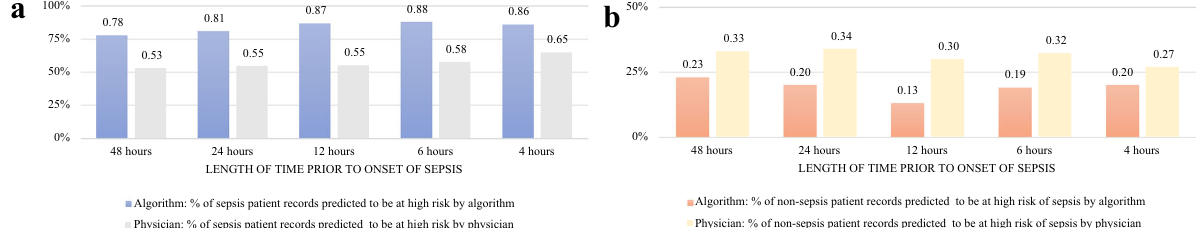
Fig. 3 Comparing the performance of the SERA algorithm vs. physician. a The bars represent the percentage of sepsis patient records correctly fl agged as having a high risk of sepsis (likely to have sepsis) by either the algorithm or physicians. The chart compares the true positive rate of the algorithm ’ s prediction at different lengths of time before the onset of sepsis against the true positive rate of physicians ’ prediction in the hospital. b The bars represent the percentage of non-sepsis patient records erroneously fl agged as having a high risk of sepsis (likely to have sepsis) by either the algorithm or physicians. The chart compares the false-positive rate of the algorithm ’ s prediction at different lengths of time before the onset of sepsis against the false-positive rate of physicians ’ prediction in the hospital.